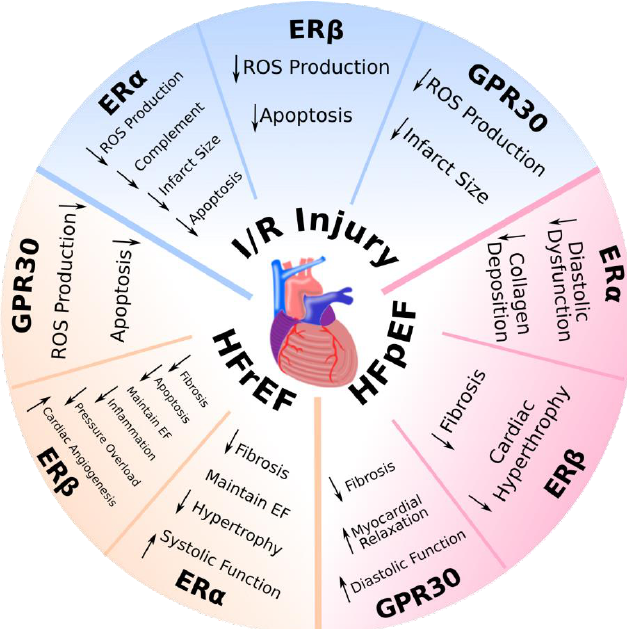
Figure 2. The role of estrogen receptors in heart disease: ischemia/reperfusion injury, heart failure with reduced ejection fraction, and heart failure with preserved ejection fraction. Depicted pathways have been shown to be involved in animal models of cardiovascular disease. EF: ejection fraction; ERα: estrogen receptor alpha; ERβ: estrogen receptor beta; GPR30: G-protein-coupled estrogen receptor; HFpEF: heart failure with preserved ejection fraction; HFrEF: heart failure with reduced ejection fraction; I/R injury: ischemia/reperfusion injury; ROS: reactive oxygen species; : increased; : decreased.